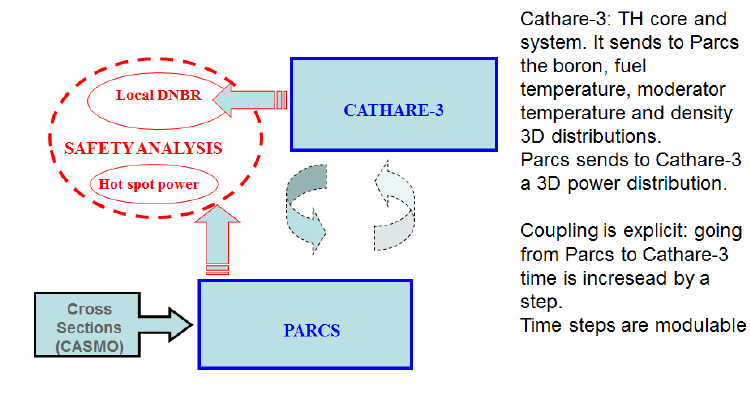
Figure 1: ANTARES